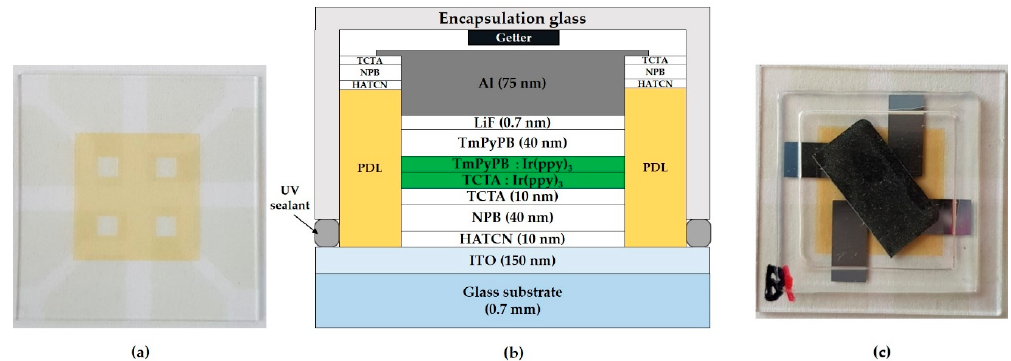
Figure 2. ( a ) ITO glass substrate image with patterned ITO and pixel-defined layer (PDL); ( b ) structure of green pixel patterned electroluminescent device used in this work; ( c ) the image of the encapsulated organic light-emitting diode (OLED) substrate covered with a moisture remover-containing glass